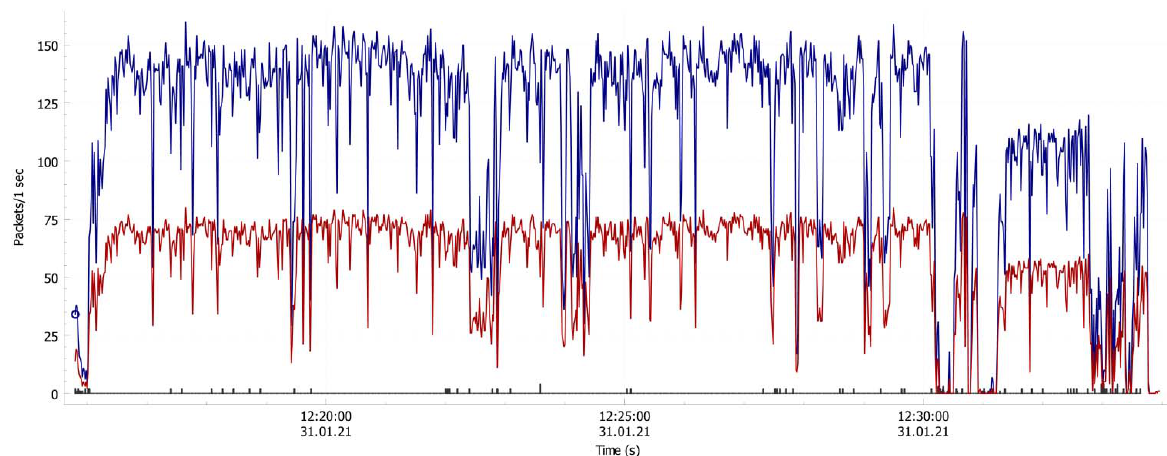
Figure 8. Traffic load for scenario 3, with four nodes and no packet sending delay. A higher traffic load was achieved with the usage of 10 sensor nodes in scenario 4. This traffic load is shown in Figure 9, where the number of MQTT packets sent to the server, the MQTT packets sent from a single sensor node, and the TCP errors per second are presented. The higher values (red line) represent MQTT packets send to the server from sensor nodes, middle values (blue line) represent MQTT packets sent from individ- ual sensor nodes to the server, and the lowest values (dark line close to 0) represent error packets.